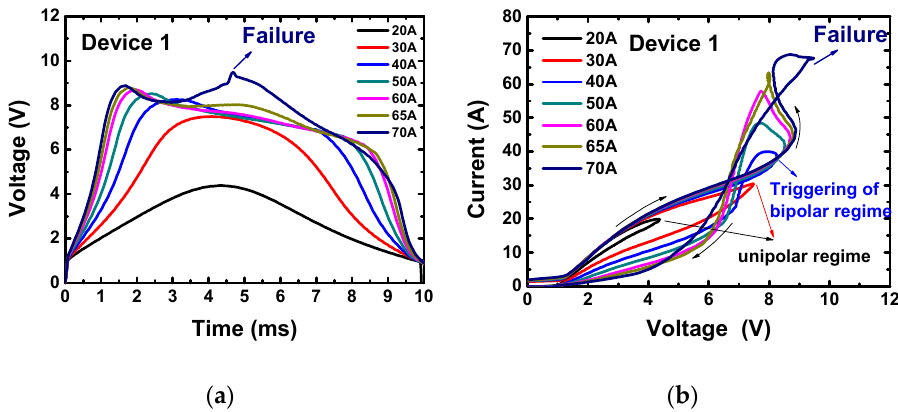
Materials 2020 , 13 , x FOR PEER REVIEW Figure 9. (a) Voltage waveforms and (b) I–V trajectories of Device 1 during the surge current tests. Figure 9. ( a ) Voltage waveforms and ( b ) I–V trajectories of Device 1 during the surge current tests.